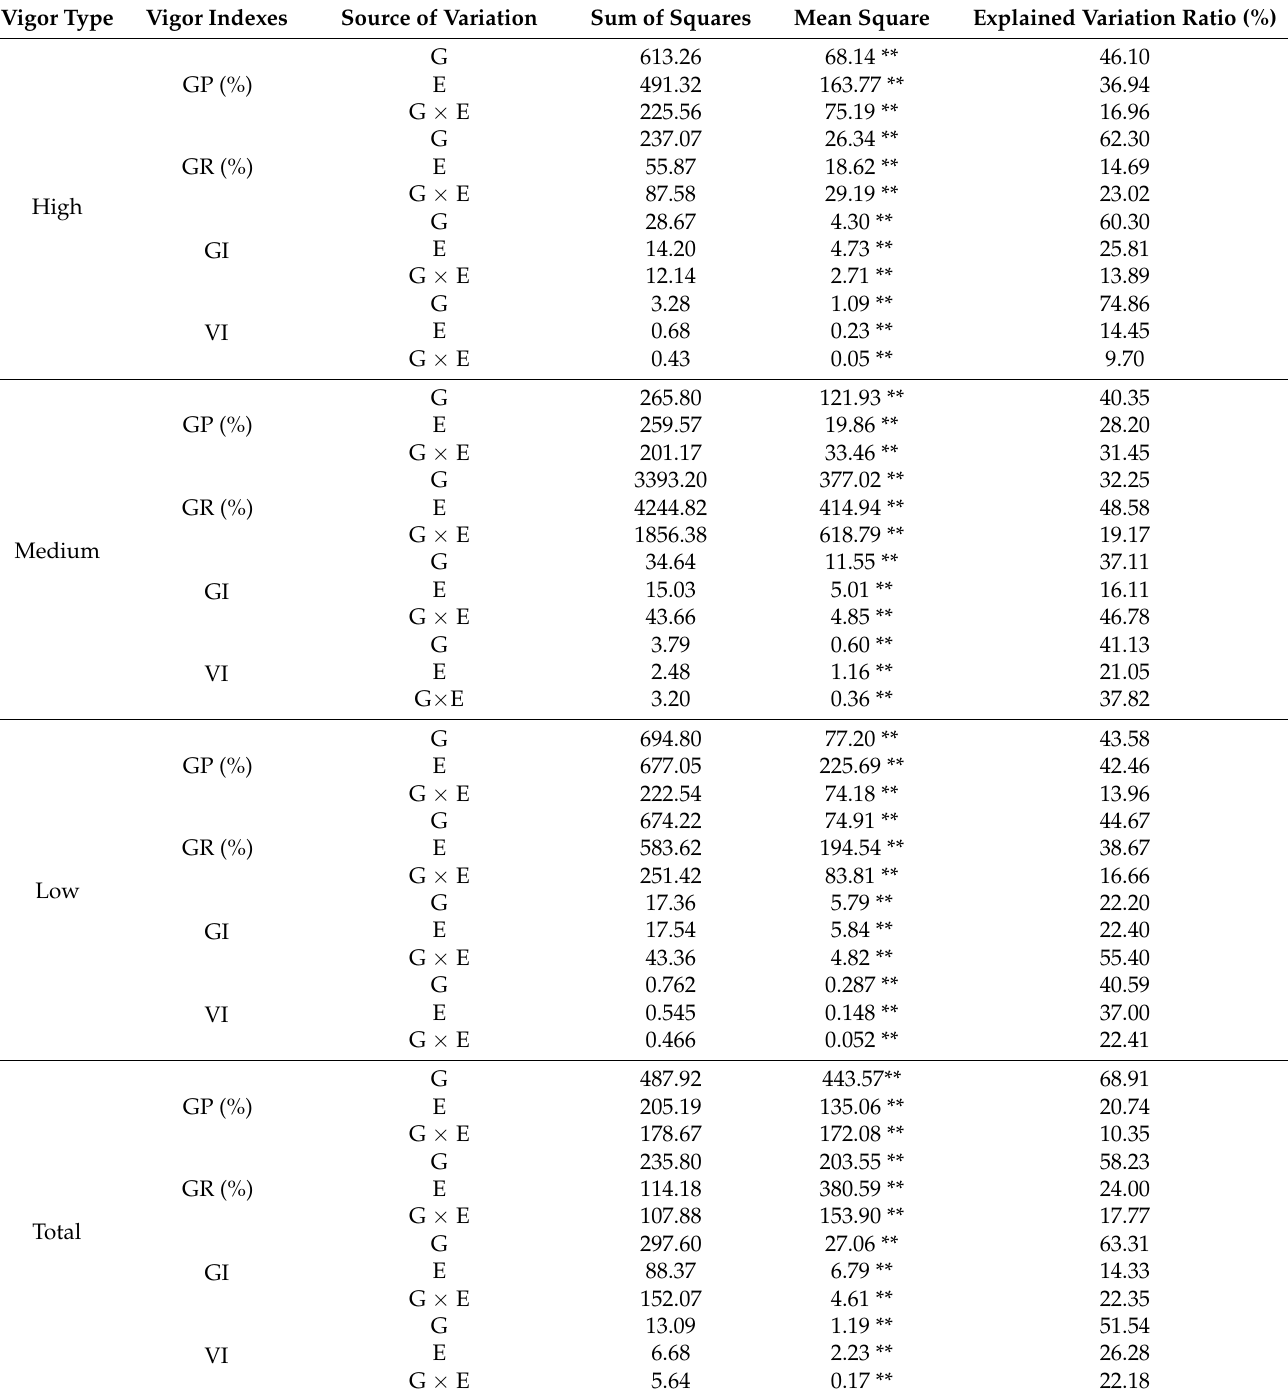
Table 7. Effects of genetic and environmental factors on the seed vigor of